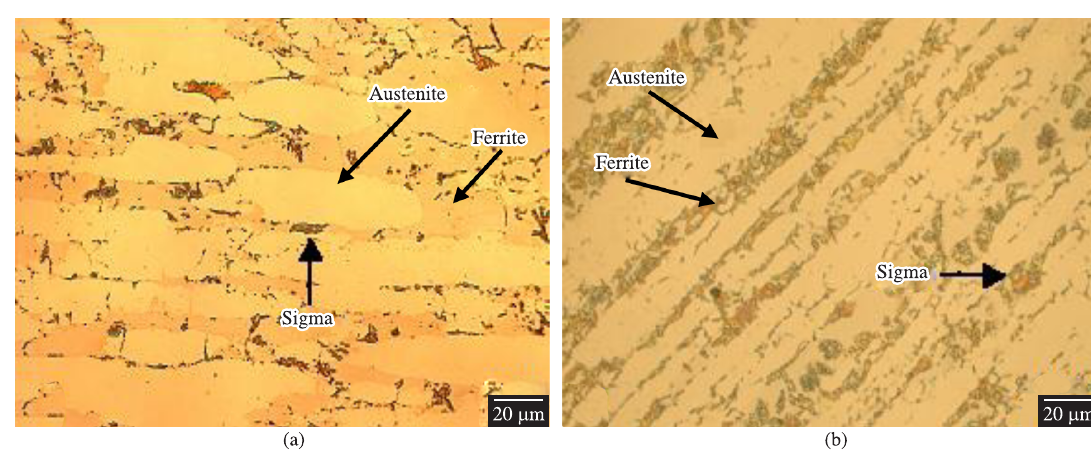
Figure 1. Microstructure of 2205 duplex stainless steel a) 850 °C-15 minutes, b) 850 °C-45 minutes.